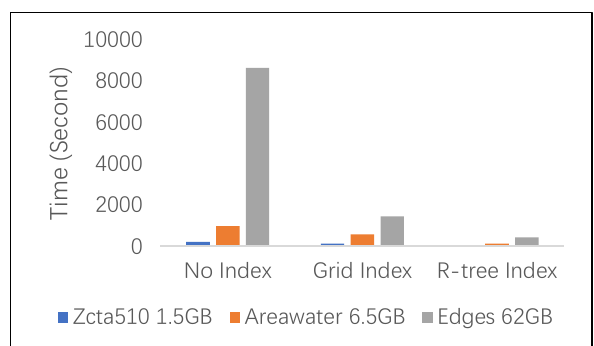
Figure 5. kNN experiments with different index and data size